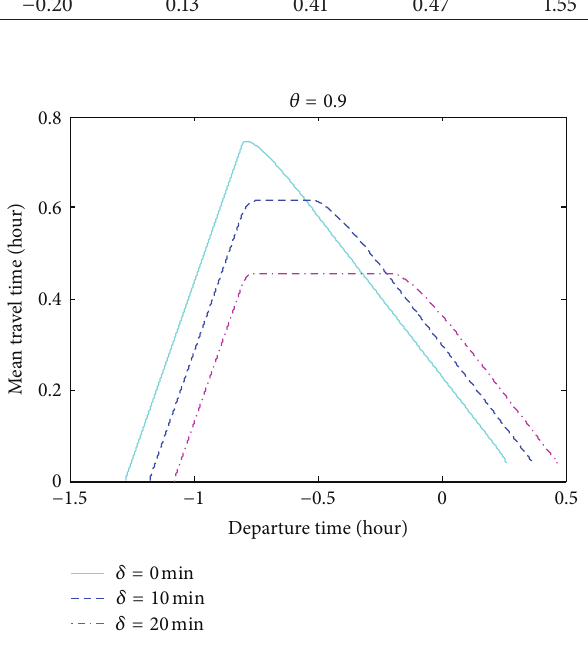
Figure 6: Travel time with different 𝛿 -value.